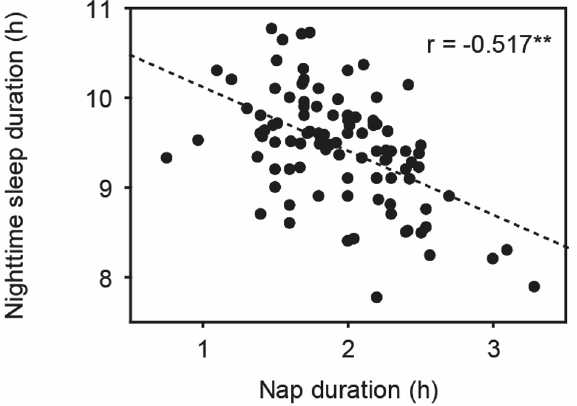
Figure 2. Correlations of nighttime sleep duration with nap duration in preterm toddlers of approximately 1.5 years of age (**p <